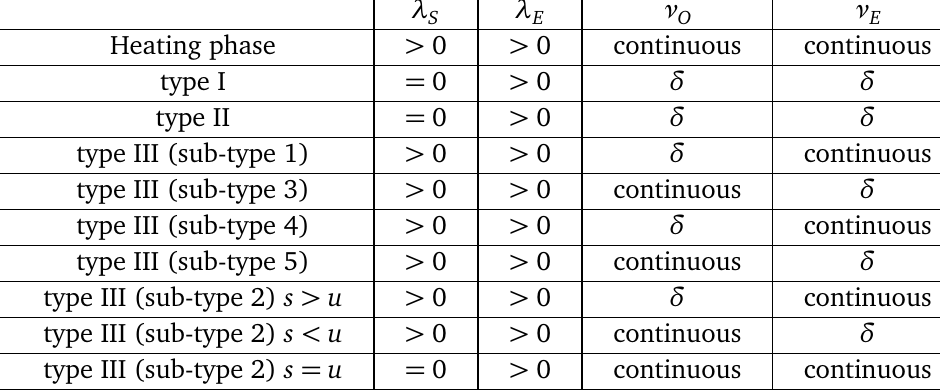
Table 1: Features in the heating phase and at different types of exceptional points. The growth rates λ and λ are for entanglement entropy (linearly) and energy S E (exponentially) as defined in (13). ν and ν denote the distributions of the operator O E evolution and the energy-momentum density peaks. s and u in sub-type-2 of type III exceptional points represent the strength of the stable and unstable fixed points (that coincide in real space) respectively. δ represents a finite convex combination of